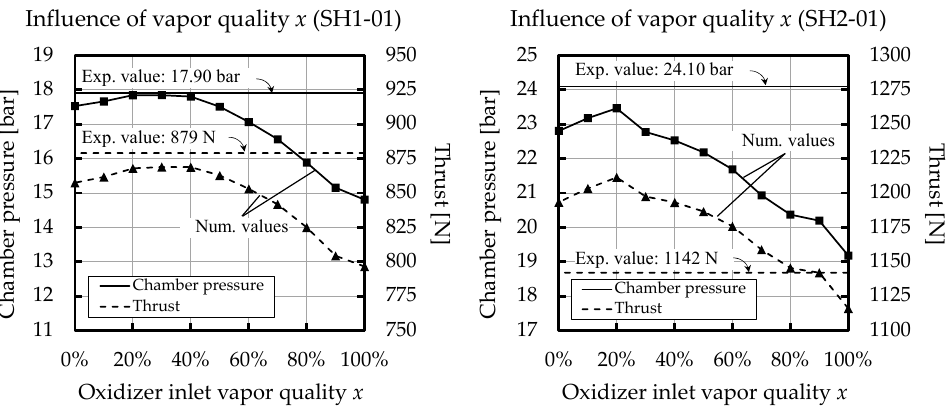
Figure 16. Impact of the vapor quality x on P ch ,num and F num for the simulations of experiments SH1-01 and